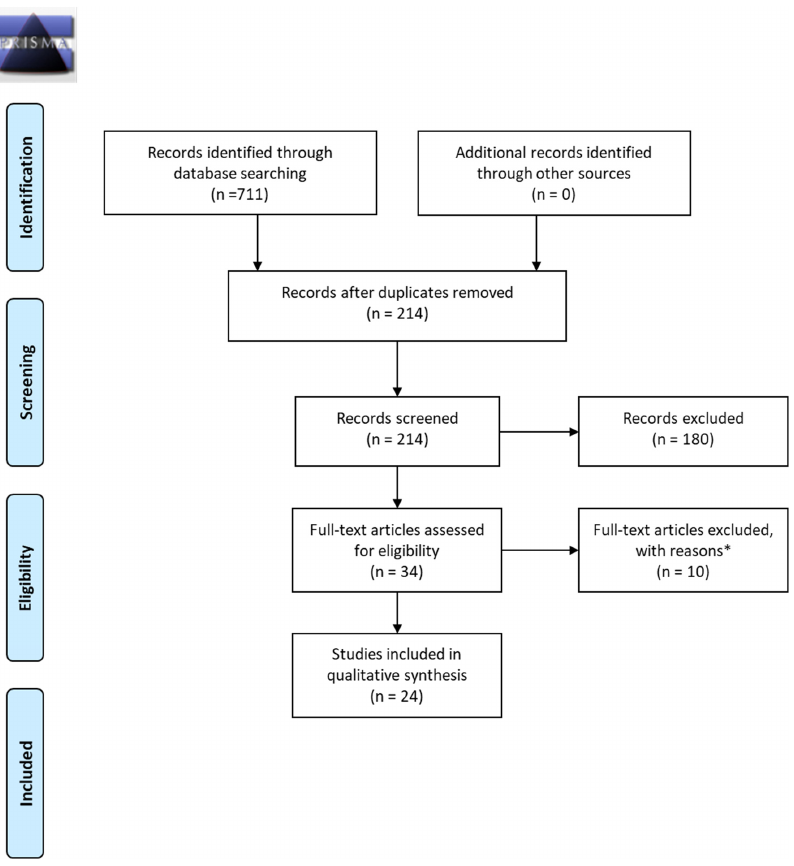
Figure 1. PRISMA 2009 Flow Diagram. * Note: Full-Text articles excluded with reasons ( n = 10): analyzed bacteria in feces rather than metabolites ( n = 4); analyzed single or <3 metabolites ( n = 5); dietary exposure unclear ( n = 1).